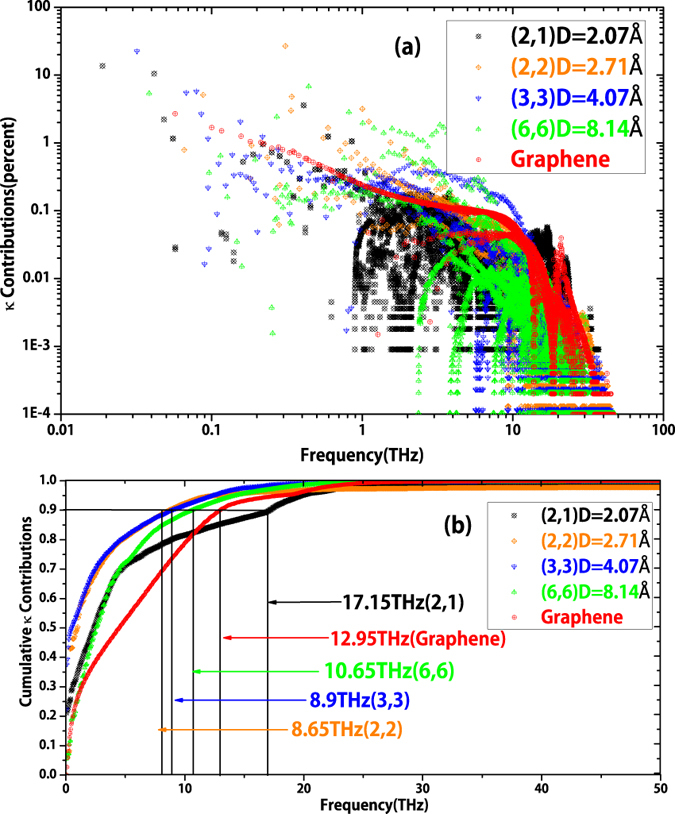
(a) κ contribution (in percentage) of each phonon mode with frequency for SWCNTs and graphene; (b) Accumulative κ contribution as functions of frequency of SWCNTs and graphene.